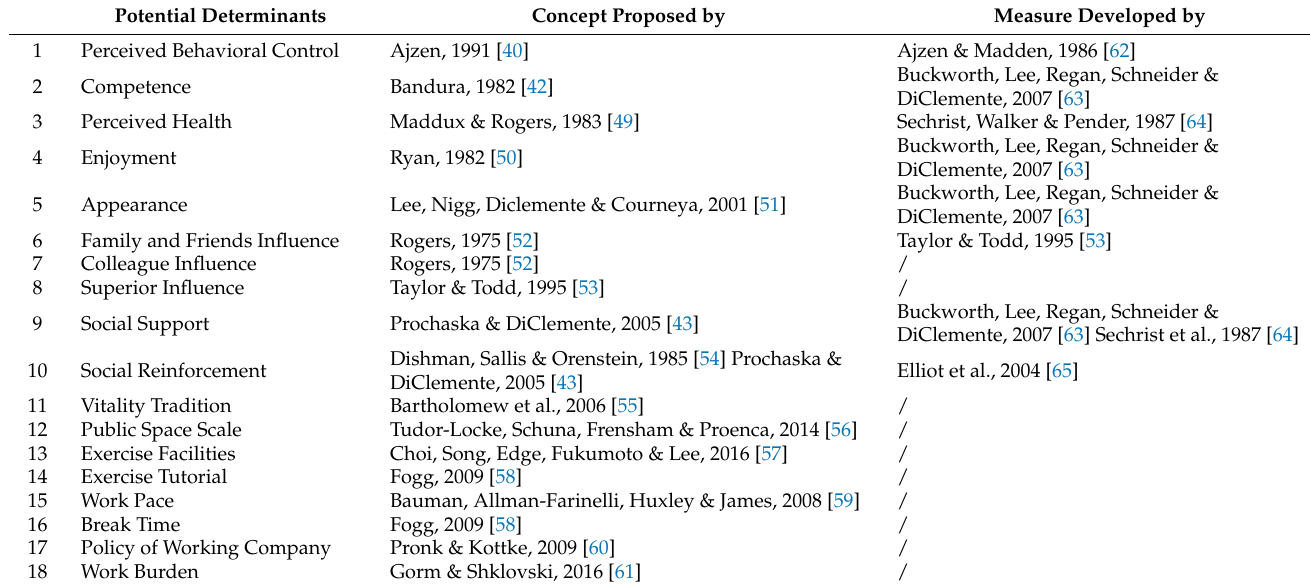
Table 1. Potential determinants of office exercise